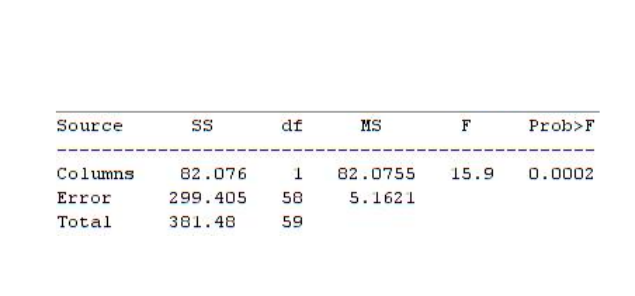
Figure 18. ANOVA test, POCID indicator.